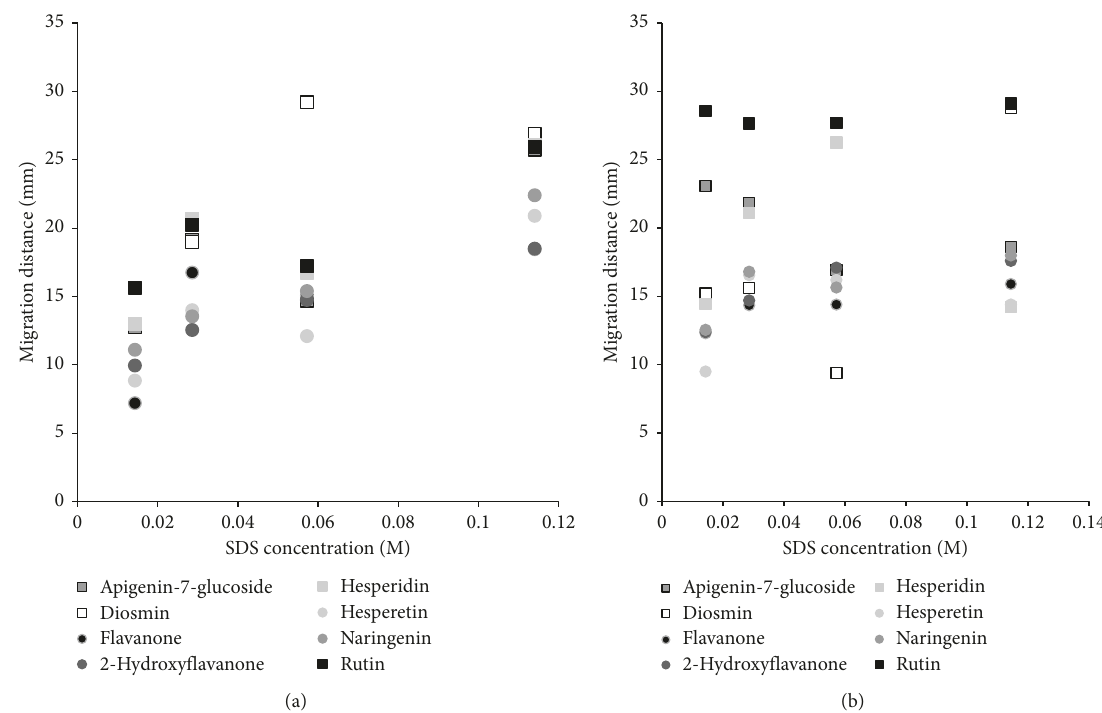
Figure 1: Migration distance of flavonoids vs. SDS concentration in the mobile phase for HPTLC (a) and PPEC (b) experiments. The mobile phase: butanol (0.89 M; 8.14% v/v), 10% acetonitrile, and SDS in the range of 0.0143 to 0.1144M aqueous buffer of pH 7.0 (0.88 mM of citric acid and 8.23mM of disodium hydrogen phosphate). The stationary phase: HPTLC RP-18W. TLC: experiment time 20min. PPEC: polarization voltage 800V; experiment time